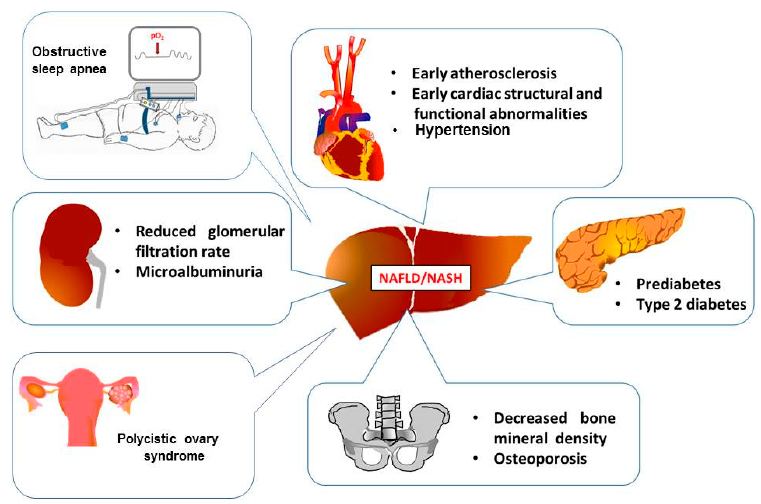
Figure 1. Extra-hepatic organ damage in youths with NAFLD.